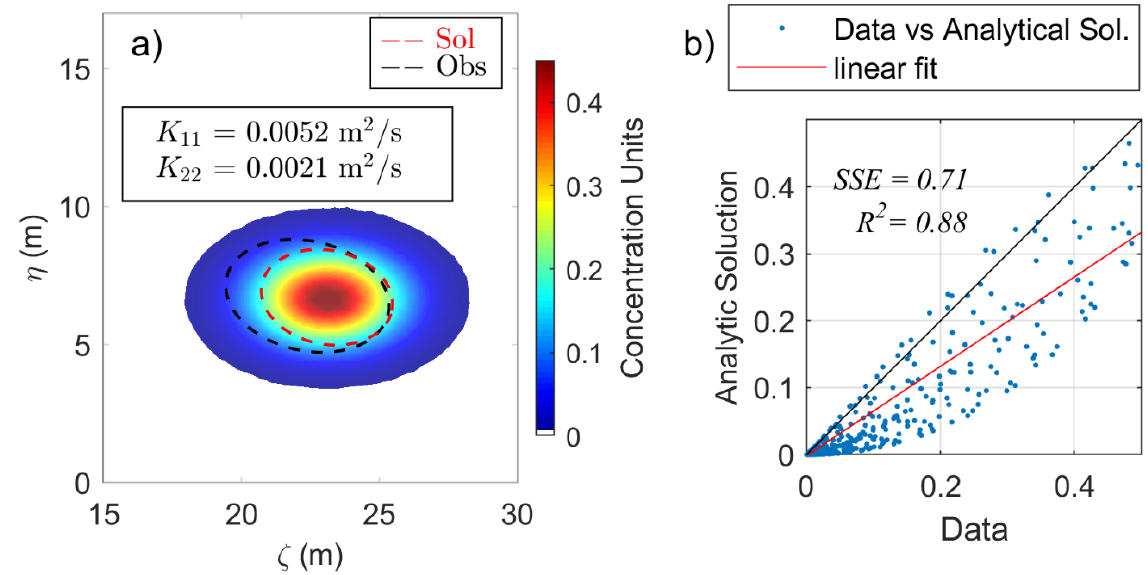
Figure 9. ( a ) Concentration contours obtained with optimal diffusion coefficients for 𝐾 11 ≠ 𝐾 22 . Observations are shown in black and the solution in red. In ( b ), the dispersion diagram of the data and the analytical solution with SSE and 𝑅 2 is shown.